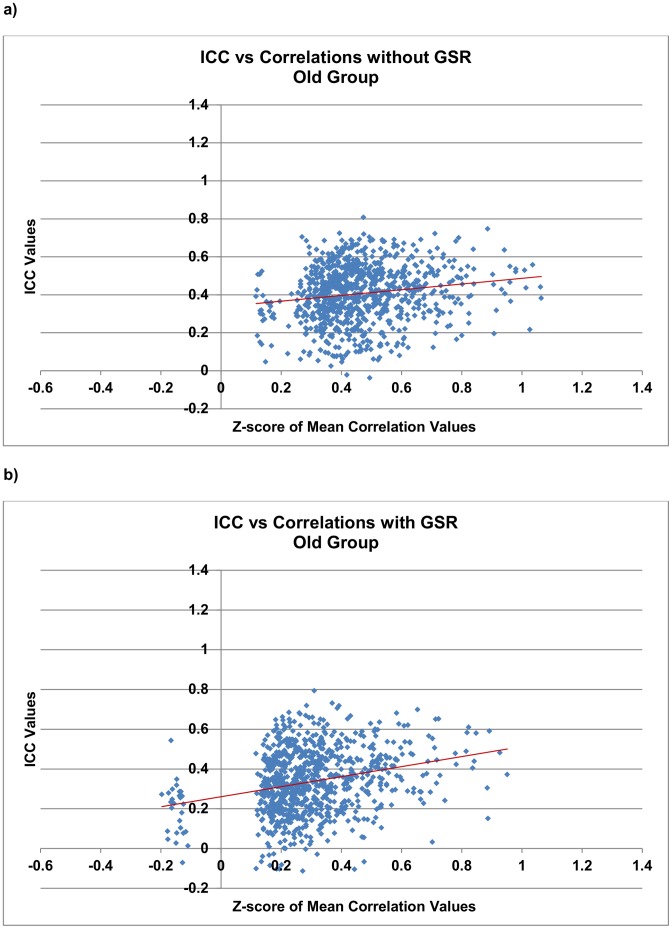
Reliability of RSFC vs. magnitude of functional connections in the old group.A left shift of data points indicates a reduction in the magnitude of functional connections when GSR is applied. The Wilcoxon signed-rank test shows reduced ICC values when GSR is applied (p-value <0.0001). Each data point represents a correlation that is significant both with and without GSR. Linear regression fits were overlaid on the data.